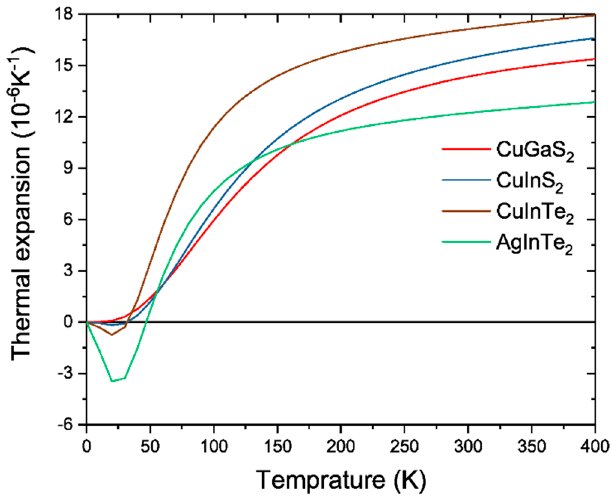
Figure 5. Volumetric thermal expansion coefficient at ambient pressure for CuGaS 2 , CuInS 2 , CuInTe 2 , and AgInTe 2 .